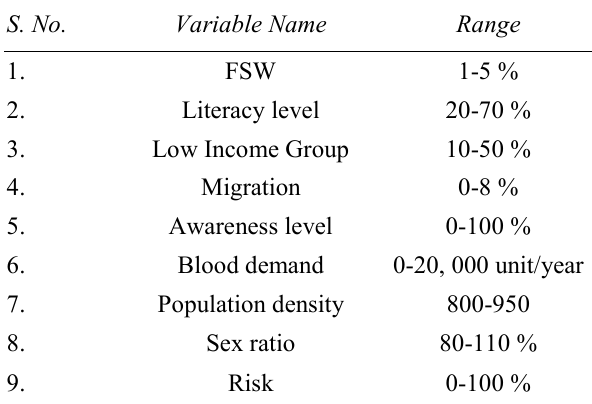
Table 5: Variables and their ranges S. No.